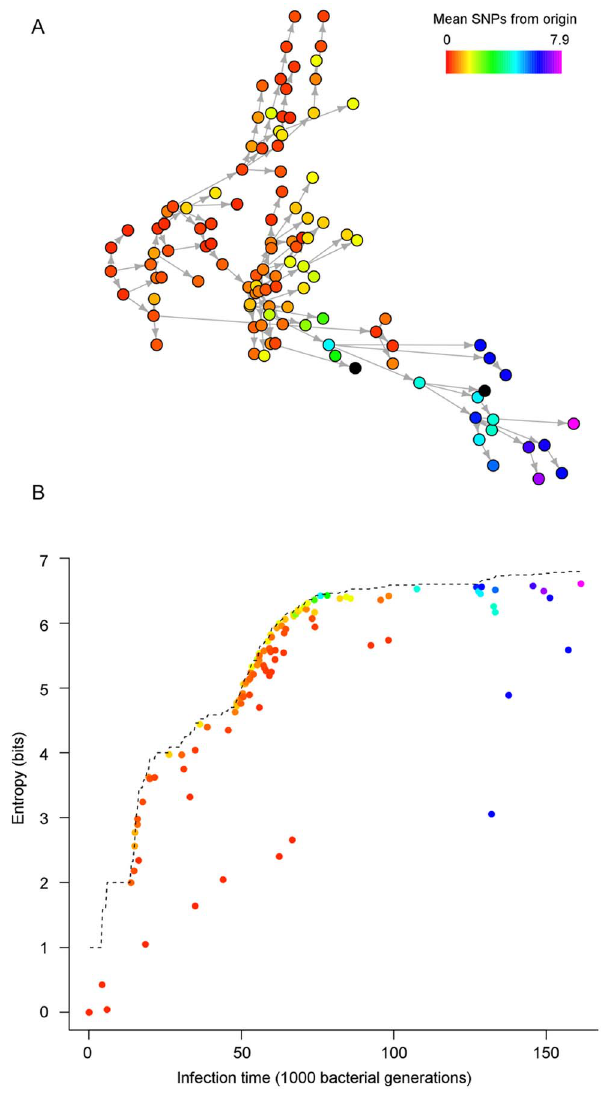
Figure 4. ( A ) Simulated SIR epidemic in a population with 250 initial susceptibles and one infective with an initially clonal infection. Samples were taken at random every 1000 generations from each individual. The color of the node indicates its mean genetic distance to the origin, based on observed sequences. Black nodes indicate individuals whose infectious period did not coincide with a sampling time. ( B ) The entropy for each node in an estimated transmission network, plotted against time of infection. The dashed line indicates the ‘no information’ case, in which sources are guessed at random (based on the order of infection only). Data were simulated with a mutation rate m ~ 1 | 10 { 4 , transmission rate b ~ 1 | 10 { 4